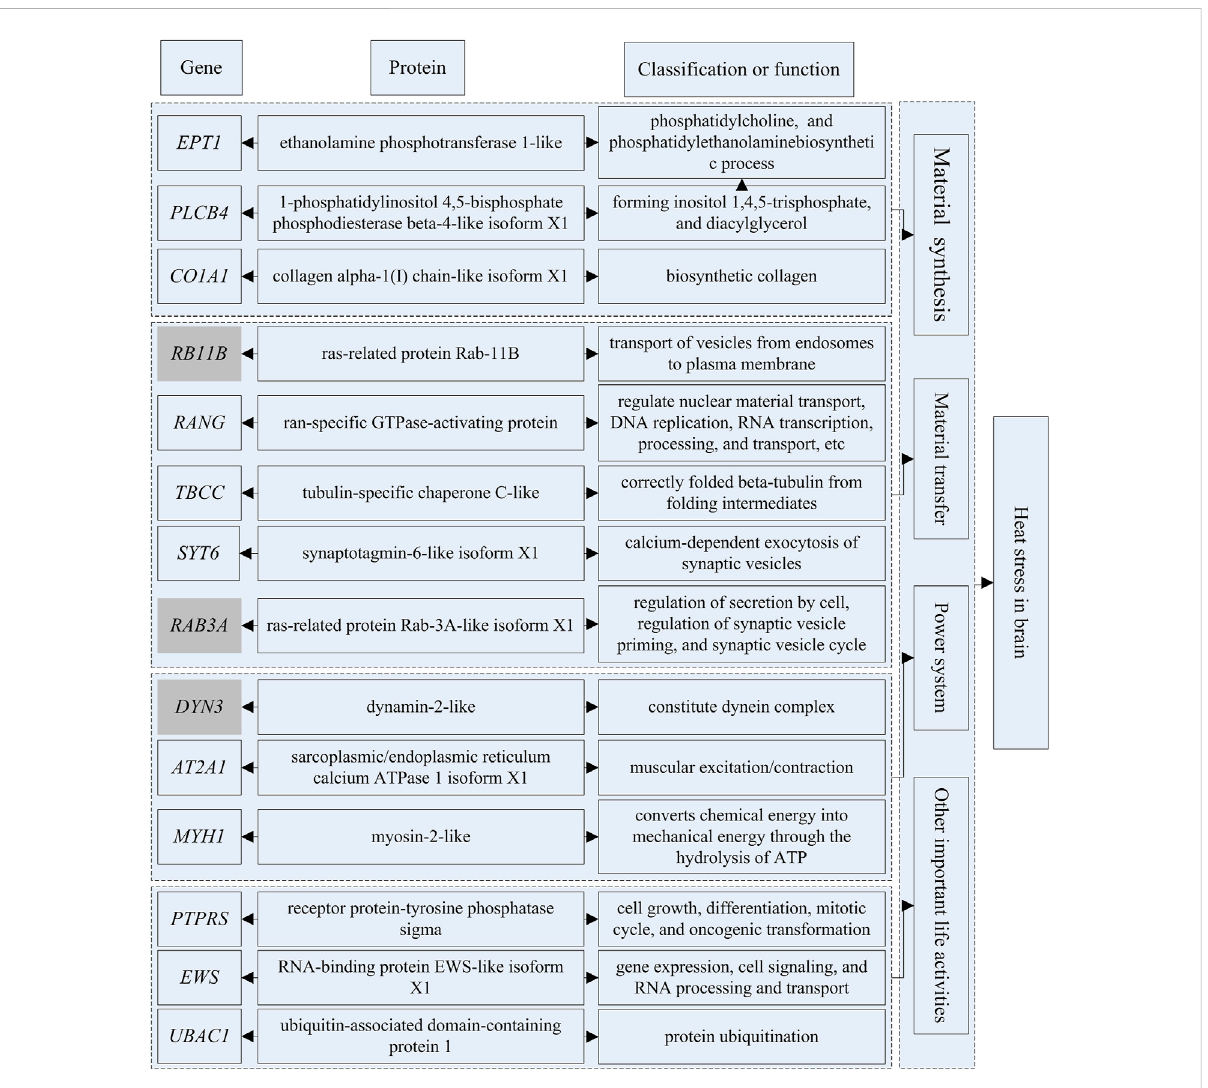
FIGURE 6 The diagram of gene-protein-potential functions in